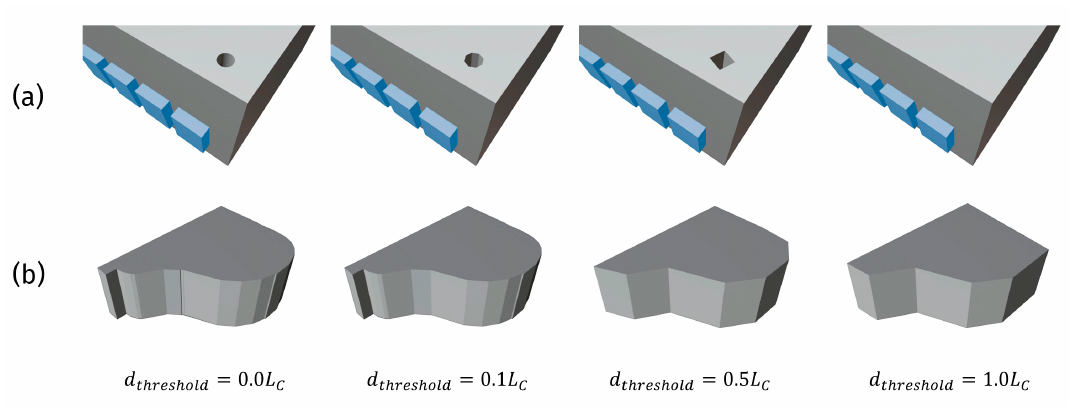
Figure 7. Simplification of building geometry with curved faces. ( a ) Space 123 of Academic Advanced Sample, ( b ) Space B112 of OTC Conference Center.